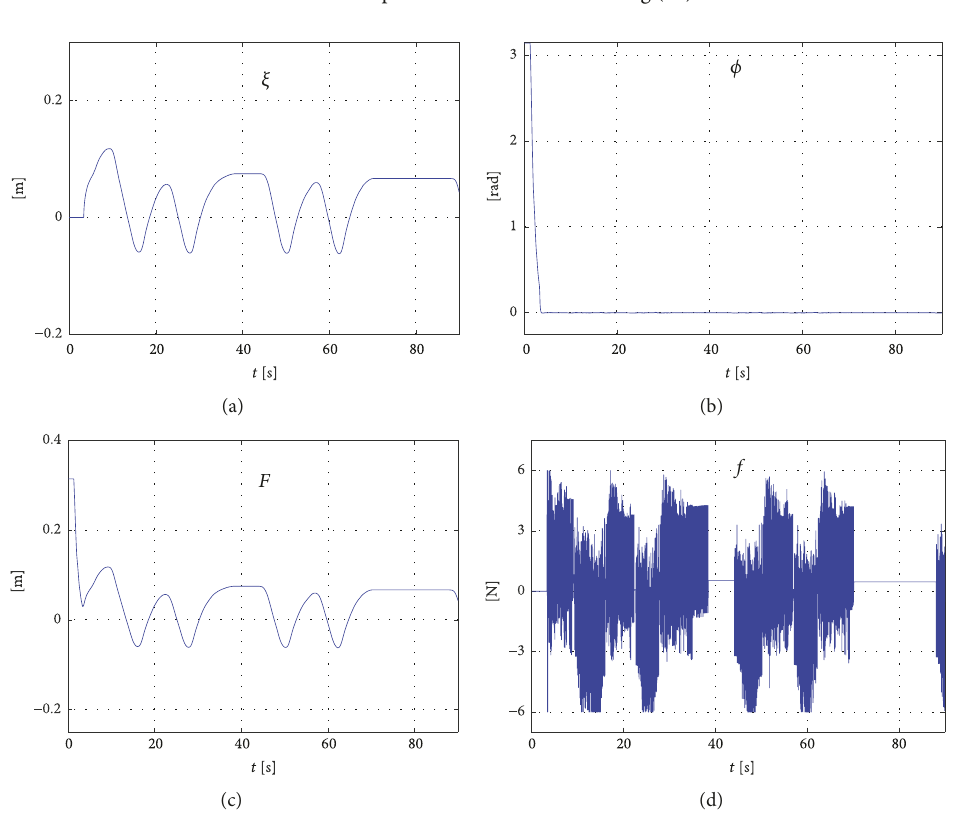
Figure 11: Experimental results when |𝐺(𝑗𝜔 𝜎 )| = 38 and 𝜔 𝜎 = 6 rad /